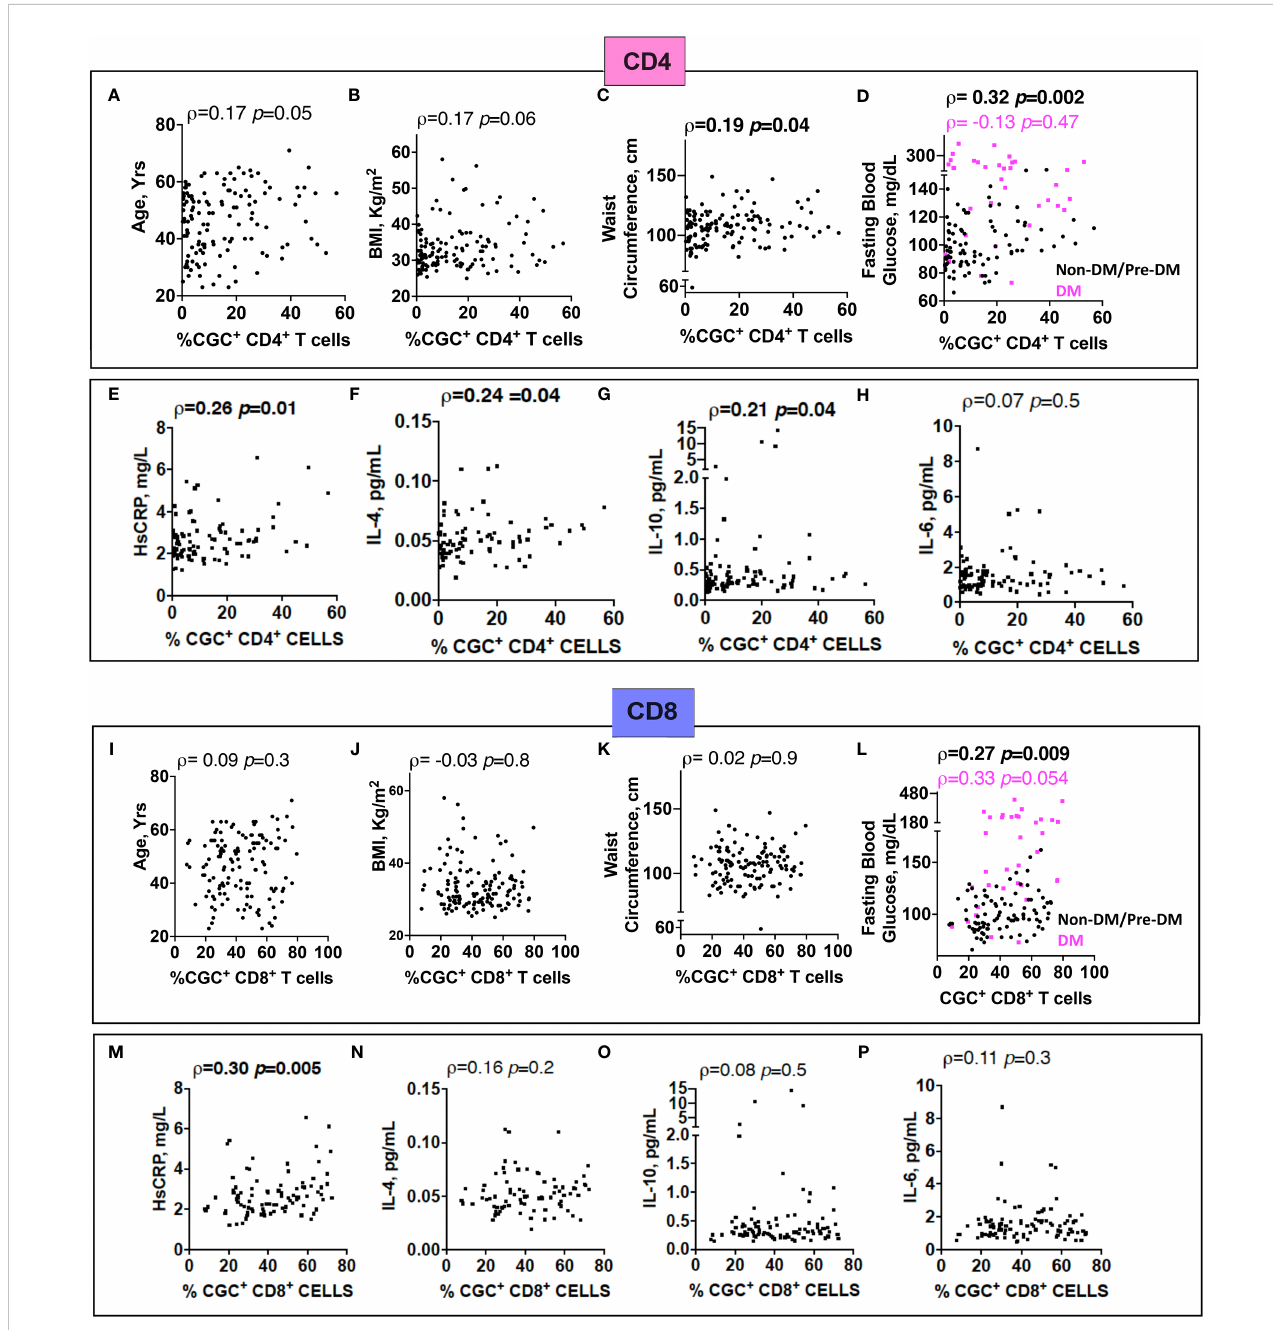
FIGURE 8 The proportion of circulating CGC + T cells in peripheral blood is correlated with fasting blood glucose. Spearman ’ s rank correlation analysis shows relationships between CGC + CD4 + T cells and age (A) , body mass index (BMI) (B) , waist circumference (C) , and fasting blood glucose strati fi ed by non- diabetic and prediabetic (black) and diabetic (magenta) (D) . Correlation plots showing relationships between % CGC + CD4 + T cells and in fl ammatory markers including high sensitivity C-reactive protein (HsCRP) (E) , IL-4 (F) , IL-10 (G) , and IL-6 (H) . Similar analyses were performed with CGC + CD8 + T cells (I-P) . Statistical analysis by Spearman ’ s rank